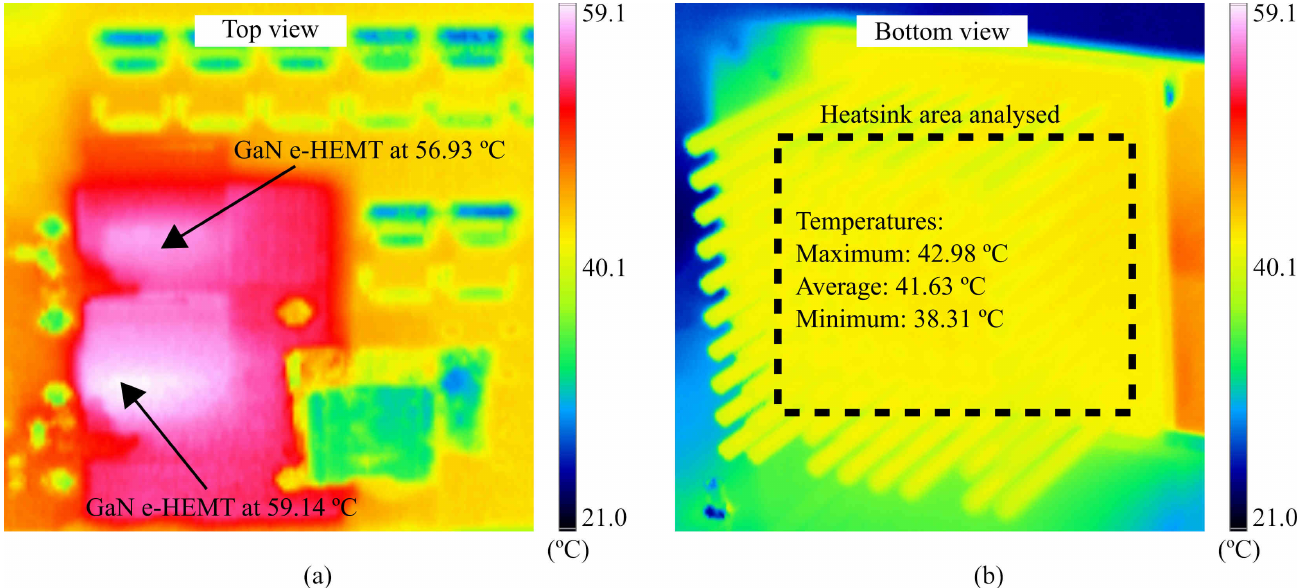
Figure 22. Thermal images of the bottom-side cooled converter: ( a ) bottom view and ( b ) top